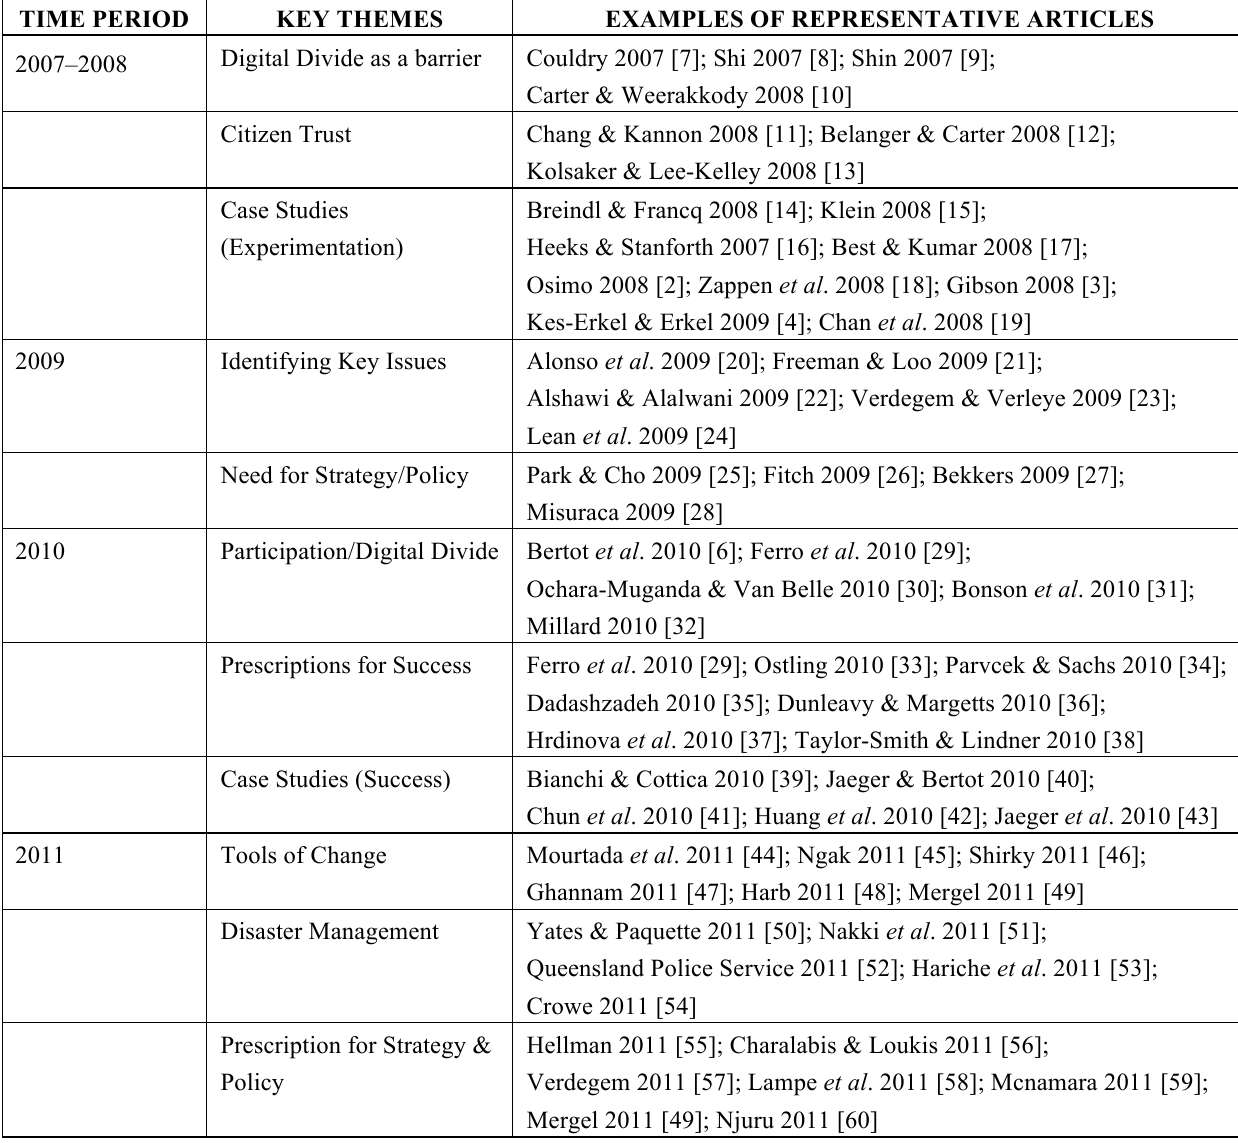
Table 1. Articles by year with key